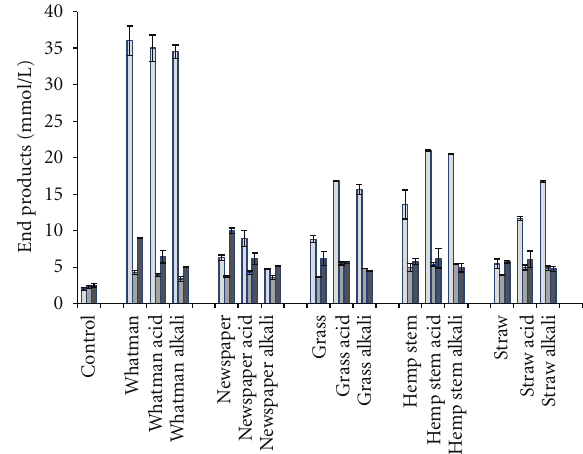
Figure 4: Production of end products from hydrolysates (4.5g · L − 1 ) from di ff erent biomasses. Values represent mean of two replicates ( ± standard deviation). From left to right: ethanol, acetate, and